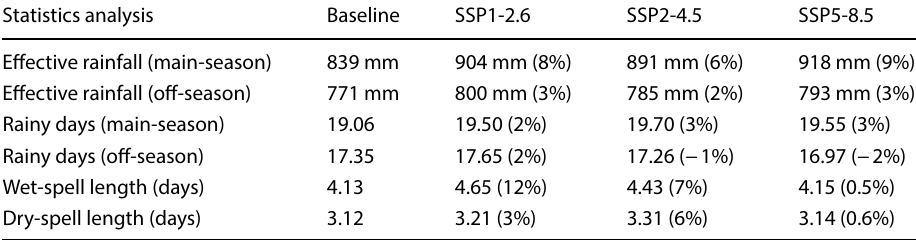
Table 5 Summary of monthly statistical analysis in rainfall parameters for baseline (1976– 2005) and future scenarios (2021–2080) with percent change from baseline